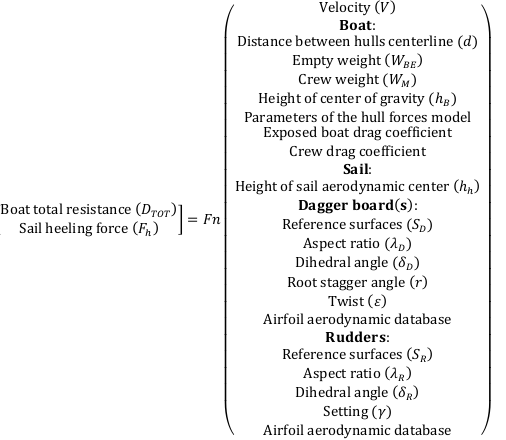
Figure 10. Scheme of the equilibrium equations